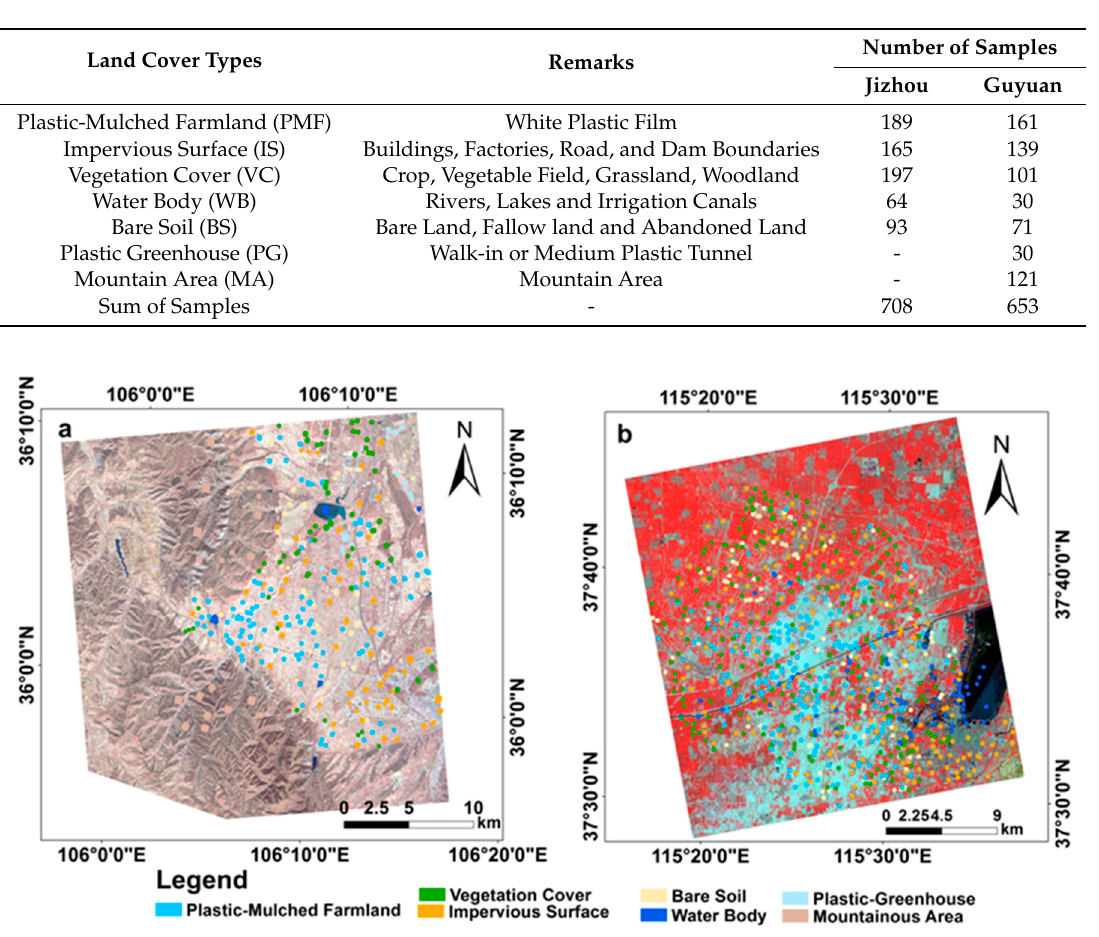
Table 2. The land cover classification scheme and the number of collected samples in Jizhou and Guyuan.